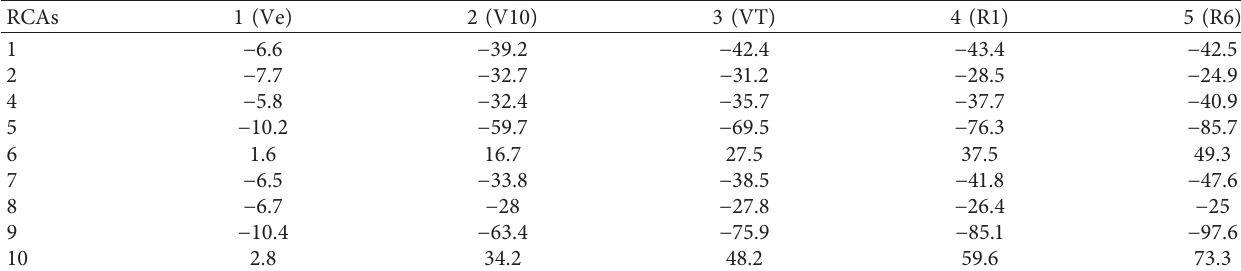
Figure 7: Accumulated degree days per phenological stage in the RCAs. Ve: emergence, V10: vegetative growth, VT: flowering, R1: filling of ears, R6: maturity. Table 3: Differences in accumulated degree days between the initial (1960–1985) and final period